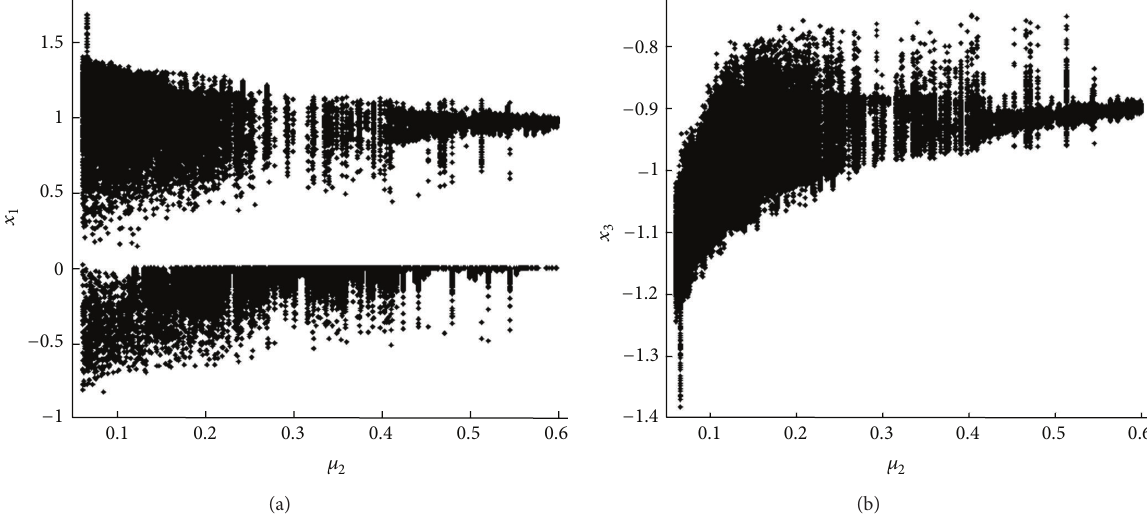
Figure 7: The bifurcation diagram is obtained for the damping coefficients 𝜇 2 = 0.06 ∼ 0.6, 𝑓 2 = 55.1 , and 𝜇 1 = 0.1 ; (a) the bifurcation diagram on the plane (𝑥 1 , 𝜇 2 ) ; (b) the bifurcation diagram on the plane (𝑥 3 , 𝜇 2 ) .